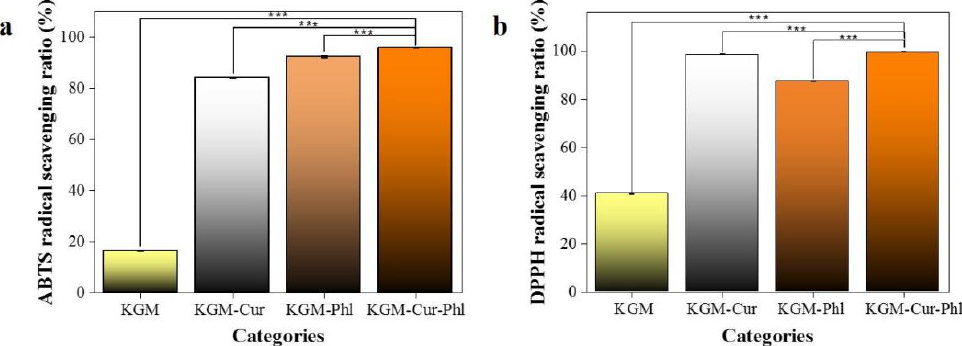
Figure 3 . The antioxidant activities of konjac glucomannan coatings: ( a ) ABTS radical scavenging capacity, ( b ) DPPH radicals scavenging ratio. *** p < 0.001.